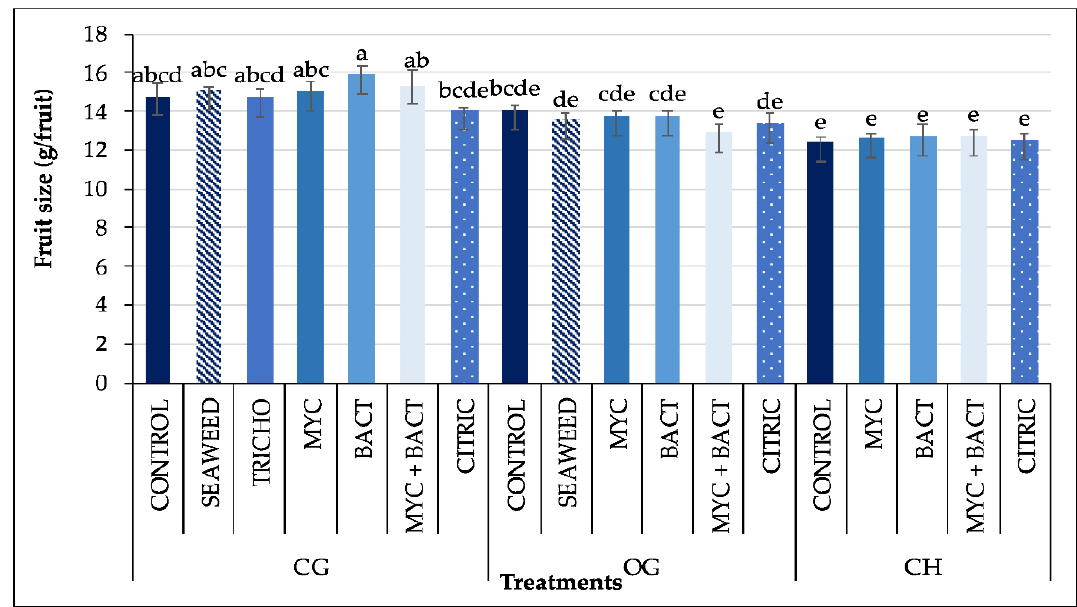
Figure 4. The influence of biostimulants and growing systems on fruit size of strawberries grown in winter under a greenhouse and in summer under a high tunnel. Means followed by the same letter are not significantly different ( p ≤ 0.05). CG: conventional greenhouse; OG: organic greenhouse; CH: conventional high tunnel; CONTROL: without biostimulant; SEAWEED: seaweed extract; TRICHO: Trichoderma , MYC: mycorrhiza ( Rhizoglomus irregulare ); BACT: three bacteria ( Azospirillum brasilense , Gluconacetobacter diazotrophicus , and Bacillus amyloliquefaciens ); MYC + BACT: a combination of treatments MYC and BACT; CITRIC: citric acid.